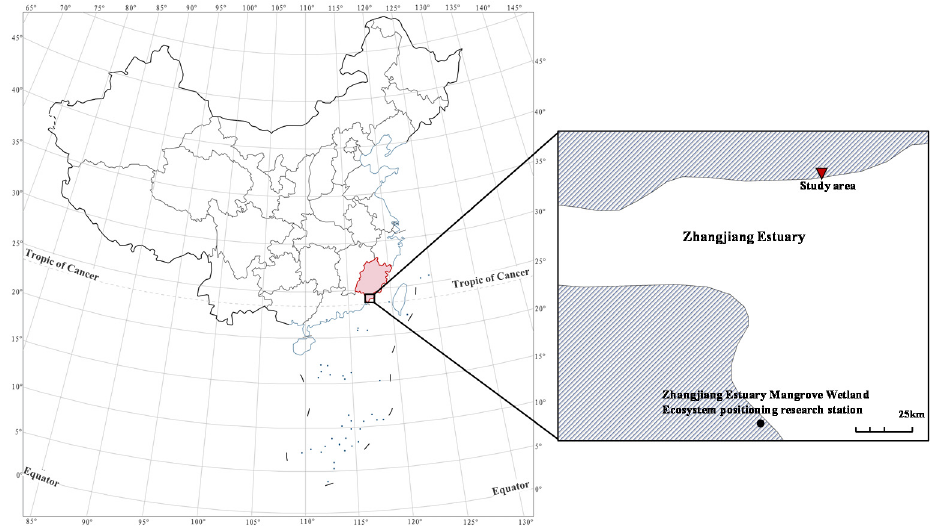
Figure 1. Study area (Zhangjiang Estuary Mangrove Wetland Reserve).